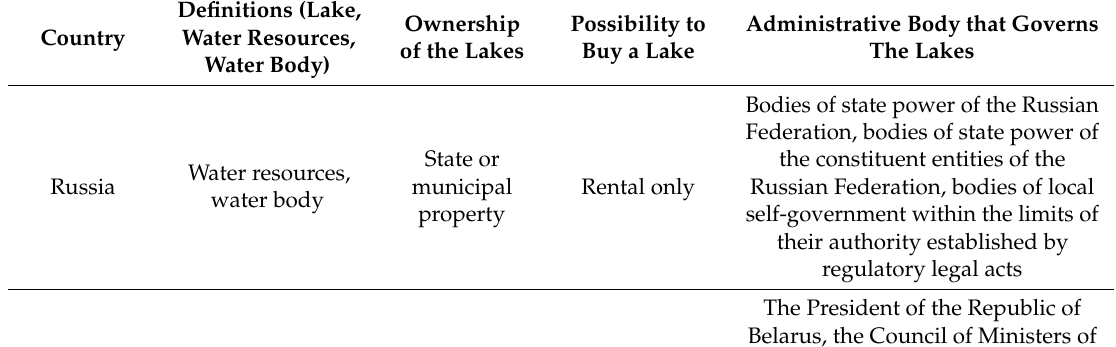
Table 1. Comparison of all Former USSR Republic Water Legislation